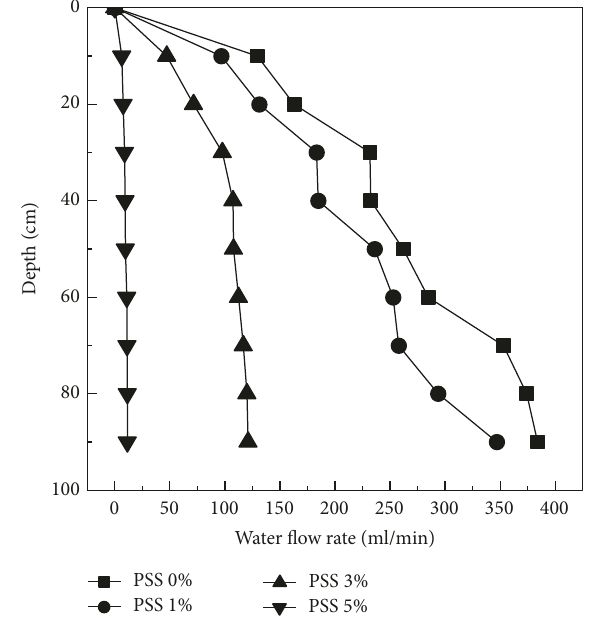
Figure 14: Variations of water flow rate ( 𝐹 ) of different depths in specimens at flow time of 12–15